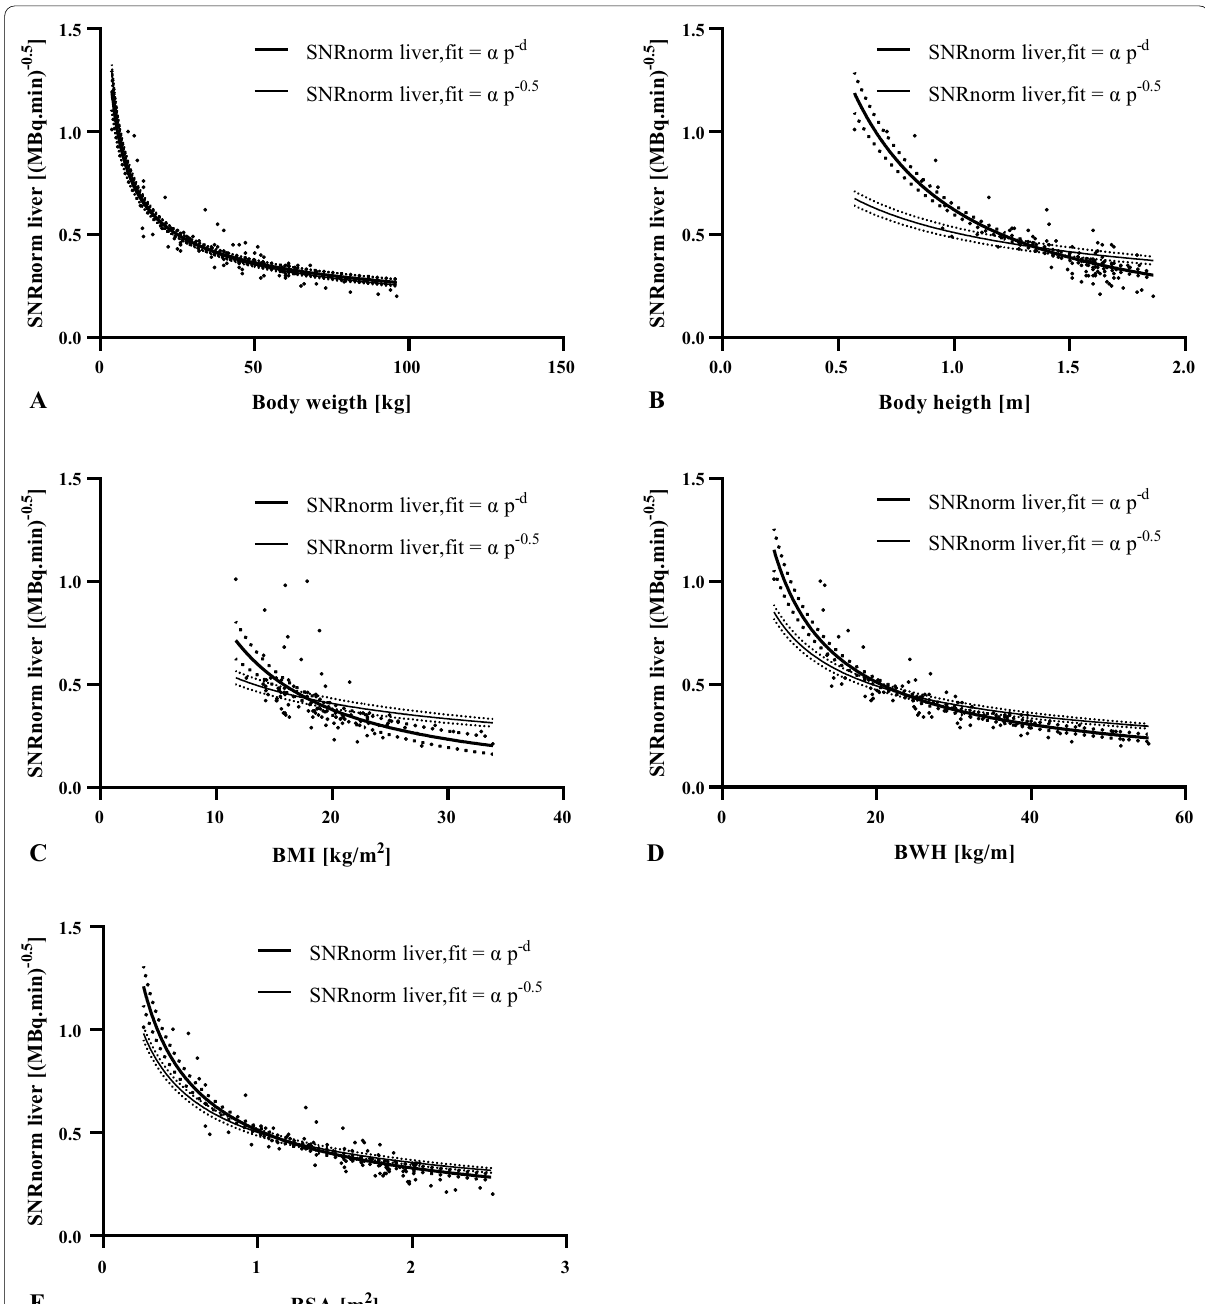
Fig. 2 Curve fitting to determine the fit parameters for a linear and nonlinear dosage regimen of the mean SNRnorm liver ([MBq body weight ( a ), body height ( b ), BMI ( c ), BWH ( e ) and BSA ( e ). The dashed lines represent the 95% confidence intervals of the